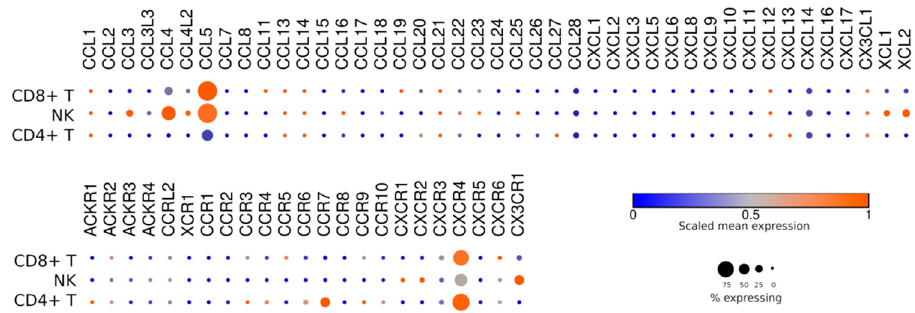
Figure 4. Homing of NK cells as well as T cells could be extensively